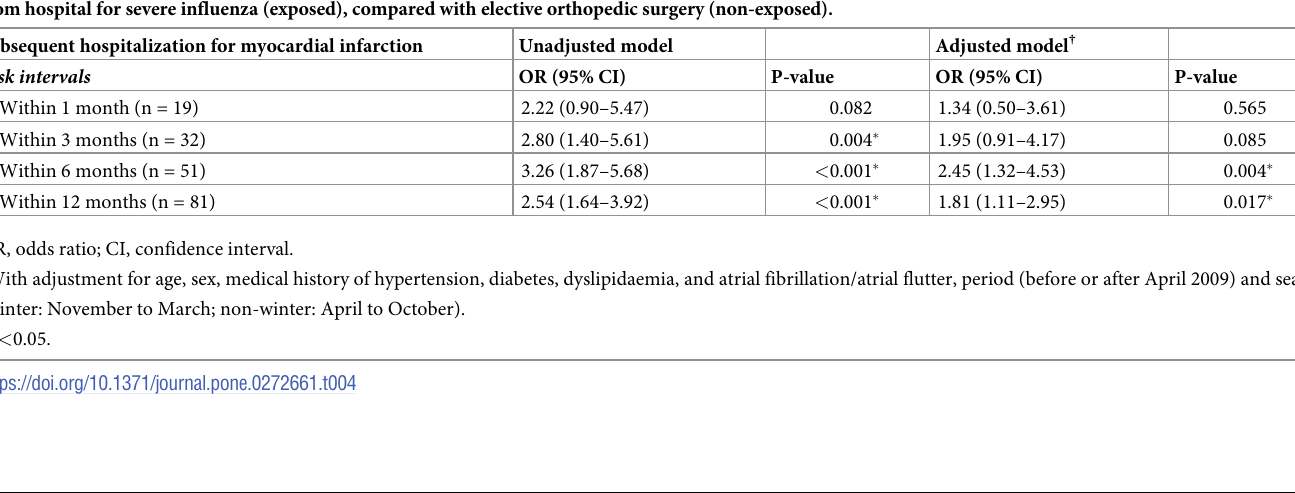
Table 4. Results from logistic regression analyses of subsequent hospitalization for acute myocardial infarction within 1, 3, 6 and 12 months following discharge from hospital for severe influenza (exposed), compared with elective orthopedic surgery (non-exposed). Subsequent hospitalization for myocardial infarction Unadjusted model Adjusted model †